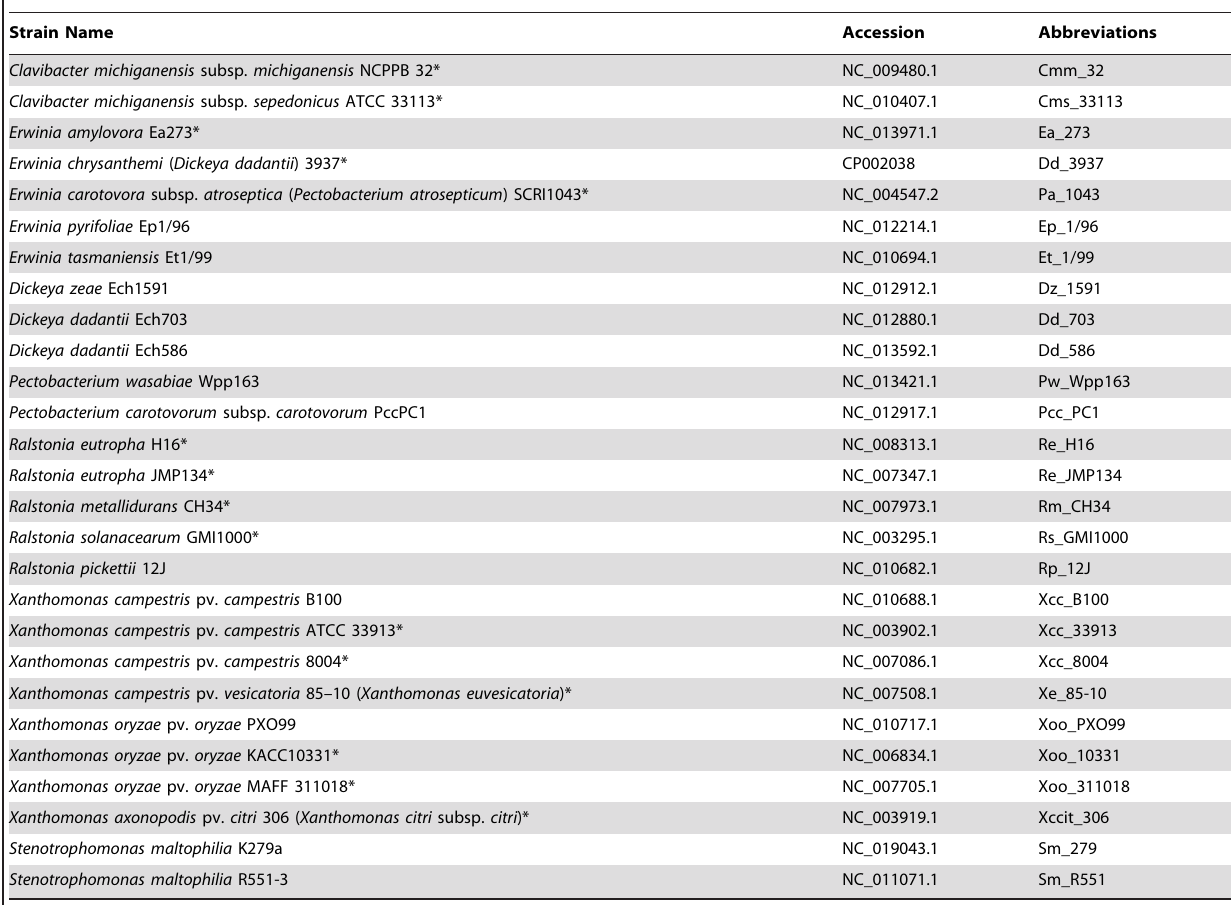
Table 1. Completely sequenced genomes discussed in this